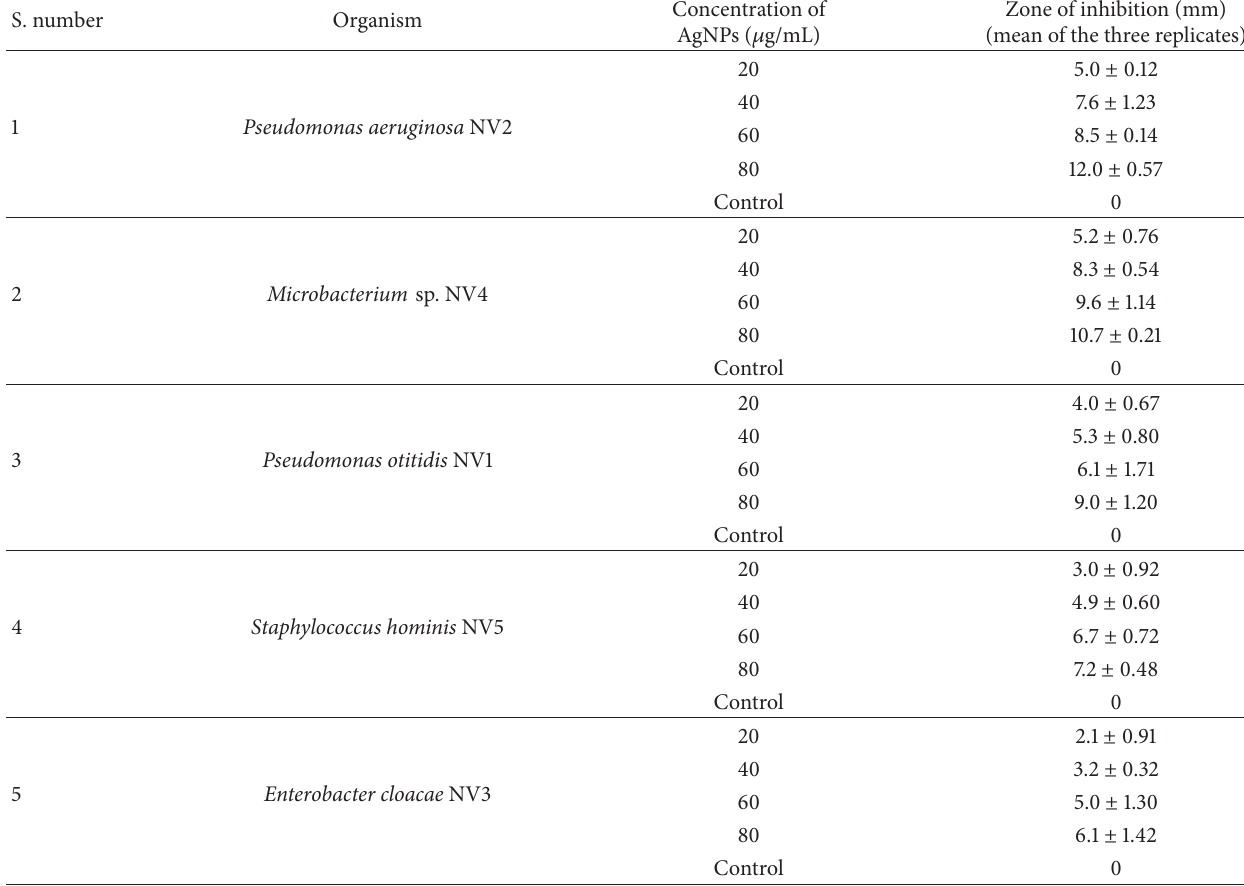
Table 1: Antibacterial activity of AgNPs against marine biofilm forming bacteria. S.